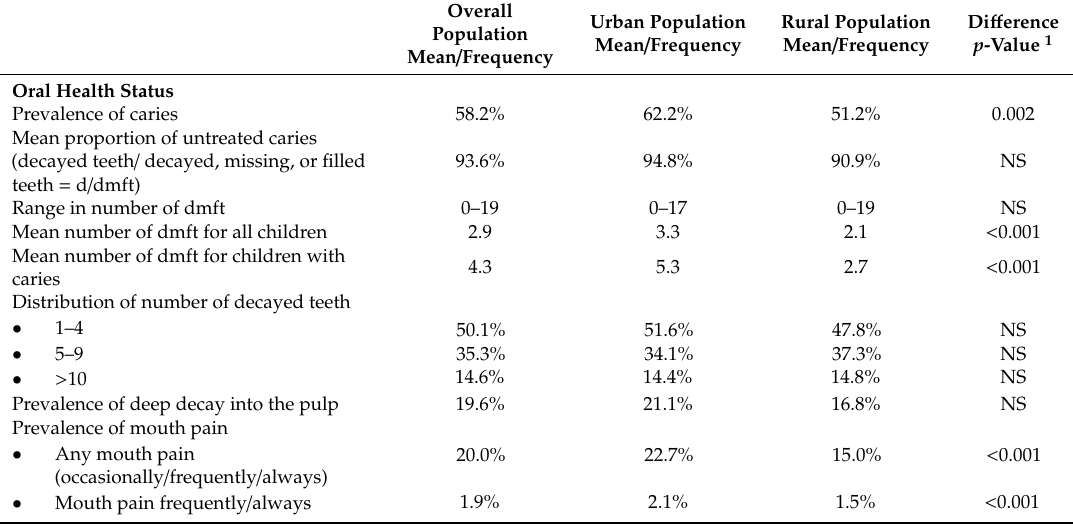
Table 3. Children’s oral health and nutrition